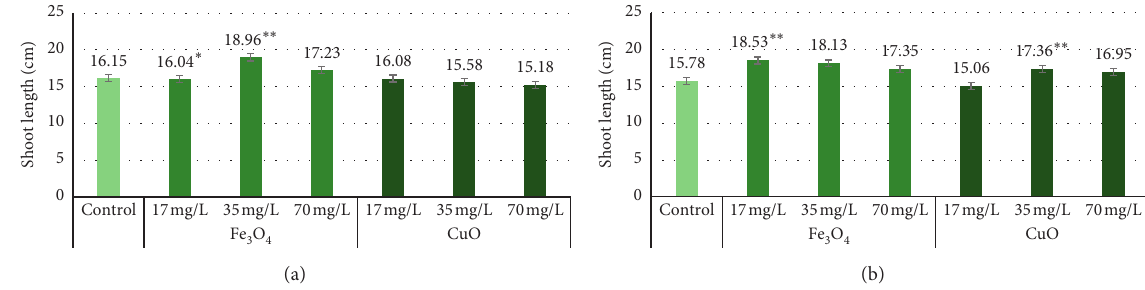
Figure 1: The “Marthe” and “KWS Olof” varieties’ shoot length with 17mg/L, 35mg/L, and 70 mg/L concentrations of Fe Values are the mean of three replicates with SD. ∗ Indicates a significant difference from control ( p < 0.05), and ∗∗ indicates a significant difference from control ( p < 0.01). (a) “Marthe” variety shoot length with different concentrations of Fe 3 O 4 and CuO NPs. (b) “KWS Olof” variety shoot length with different concentrations of Fe 3 O 4 and CuO